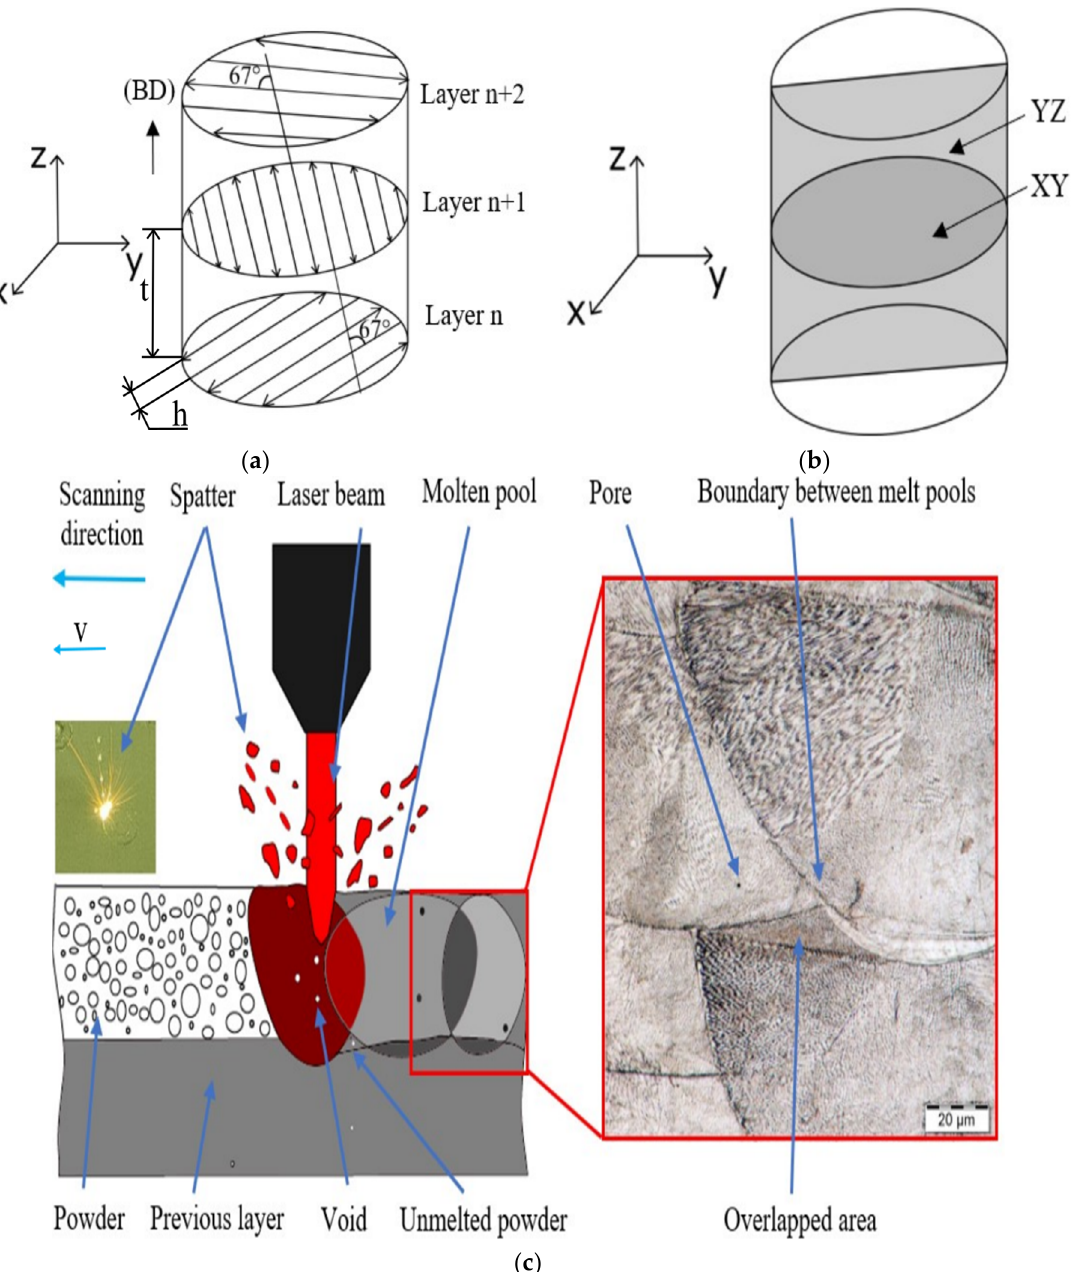
Figure 1. ( a ) Meander hatching pa(cid:308)ern, 67° rotation after each layer, ( b ) Cross-section for micro- scopic analysis, and ( c ) grain-formation mechanism during the SLM process. analysis, and ( c ) grain-formation mechanism during the SLM process. Table 1. Chemical composition of fabricated samples using SLM. Table 2. Process parameters used for fabrication of the parts using